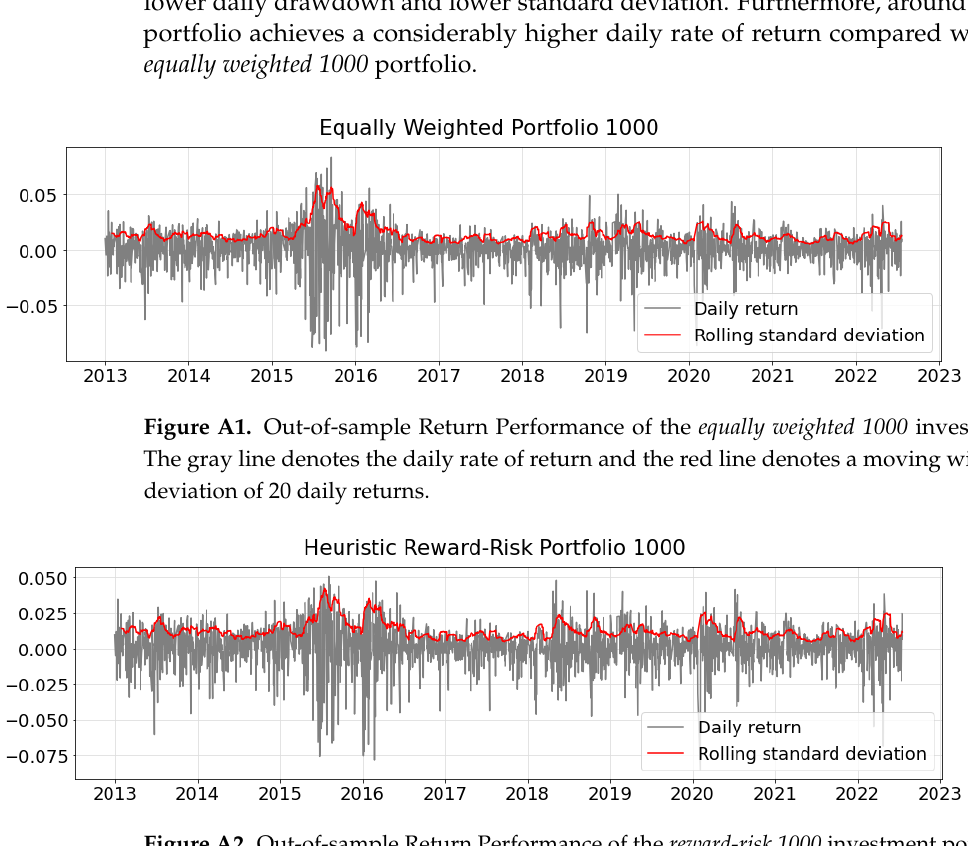
Figure A2. Out-of-sample Return Performance of the reward-risk 1000 investment portfolio. The gray line denotes the daily rate of return and the red line denotes a moving window standard deviation of 20 daily